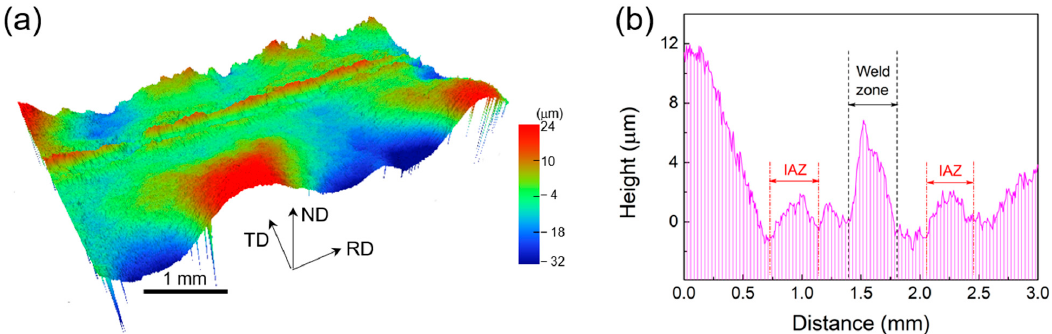
Figure 11. ( a ) 3D height contour measured on the surface of HS sample after tensile testing. ( b ) The distribution of statistical average height as a function of sample gauge width.